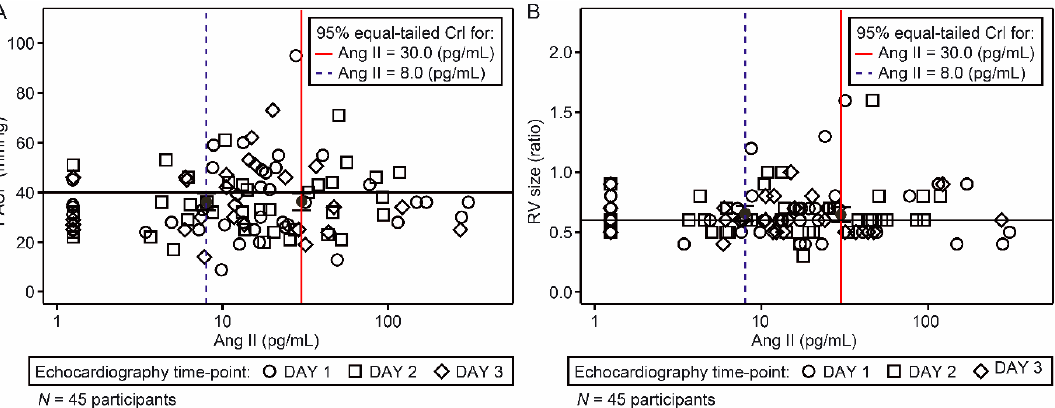
Figure 4. Scatterplots of PASP ( A ) and RV size ratio ( B ) versus Ang II concentrations, with posterior prediction regions for RV function. Data are median PASP and RV size and 95% equal-tailed credibility intervals for the corresponding ‘pre-dose’ 30 pg/mL and ‘post-dose’ 8 pg/mL Ang II. One measurement was databased per day, per participant. The horizontal reference line corresponds to the defined threshold value associated with PCD . Ang , angiotensin; CrI , credible interval; PASP , pulmonary arterial systolic pressure; RV , right ventricular.